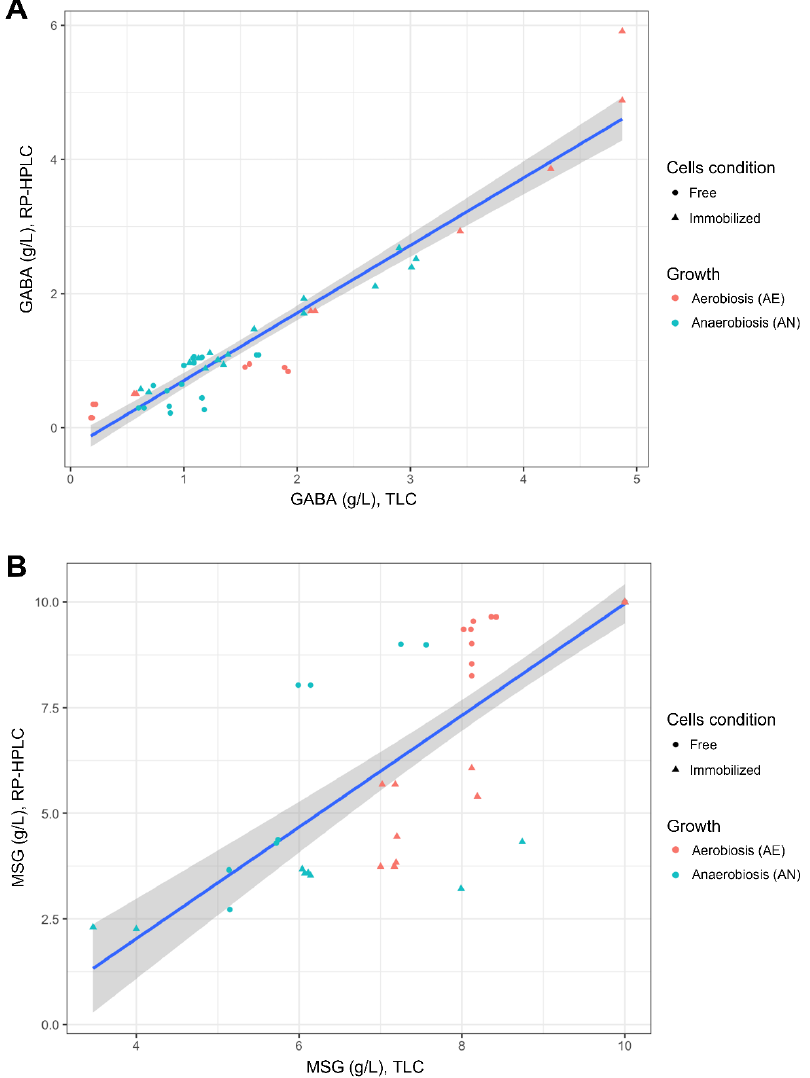
Figure 4. Correlation between the concentrations of produced GABA (g/L; panel A ) and residual glutamate (g/L; panel B ) measured in the buffer system by using Thin-layer Chromatography (TLC; Section 2.5.1) and RP-HPLC (Section 2.5.2). The cell condition (free, immobilized) and growth (aerobiosis, anaerobiosis) used for biocatalysis are described in Sections 2.4.1 and 2.4.2.